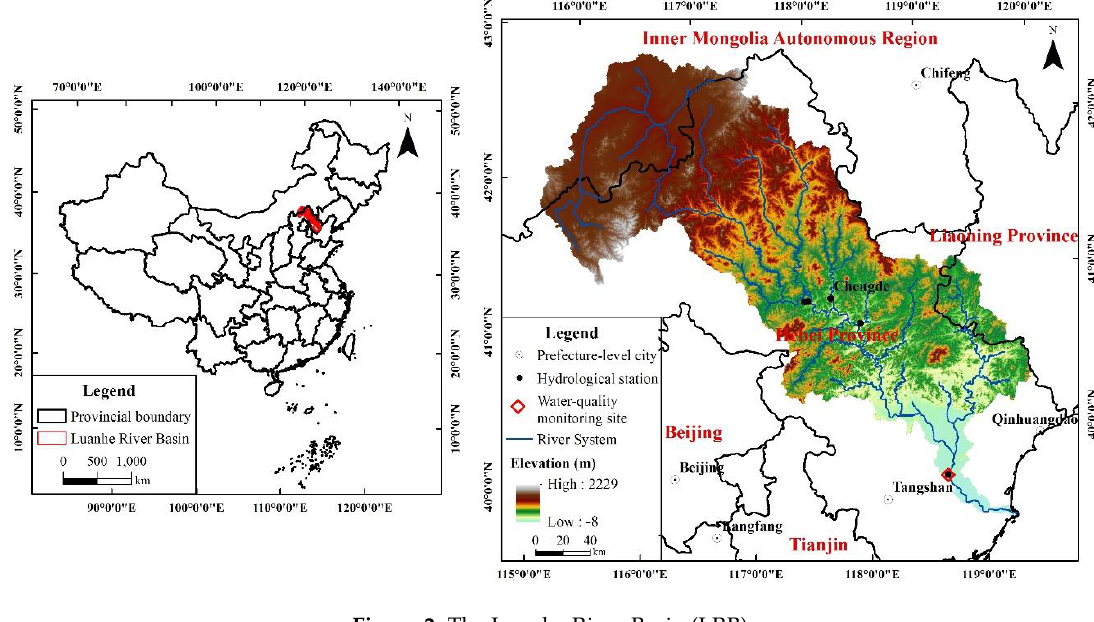
Figure 2. The Luanhe River Basin (LRB).